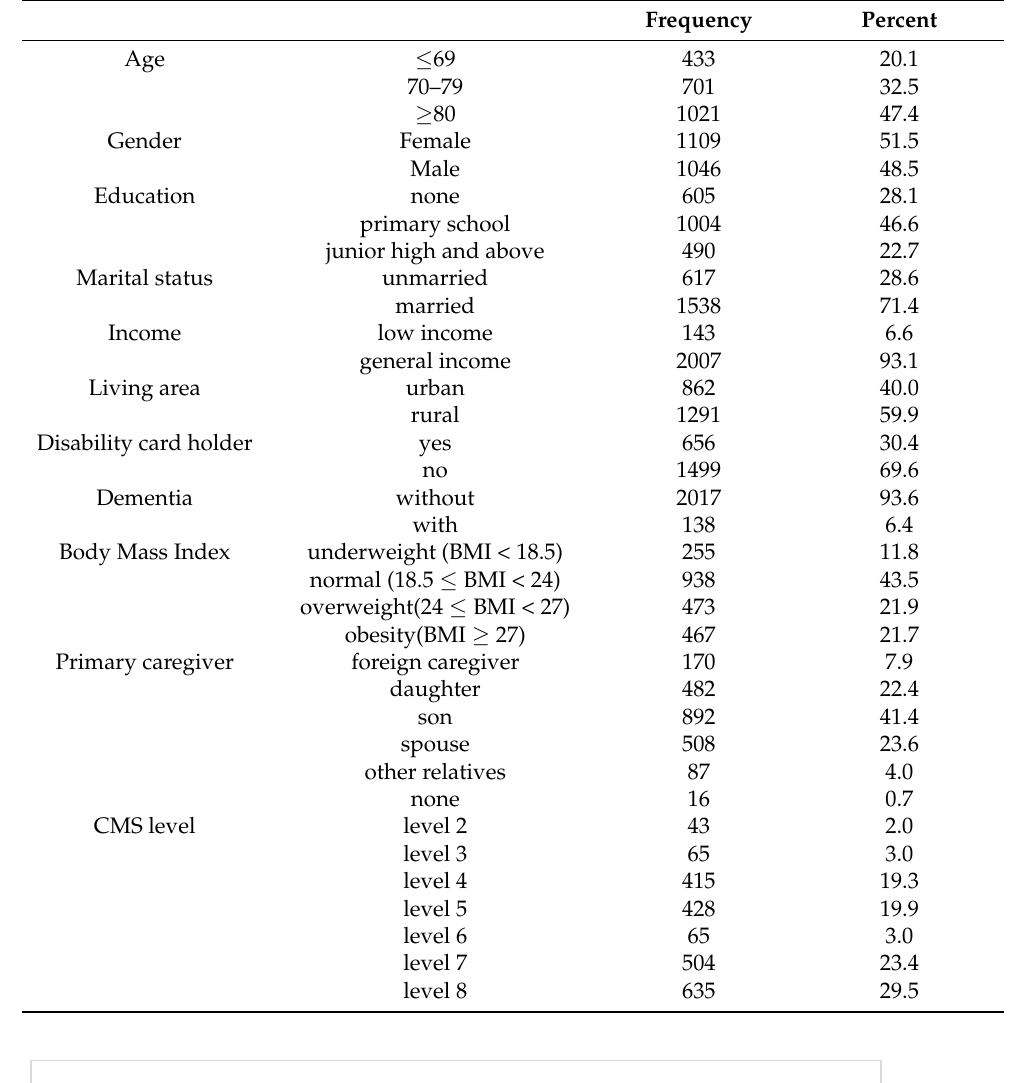
Table 1. Characteristics of the study group ( n = 2155).